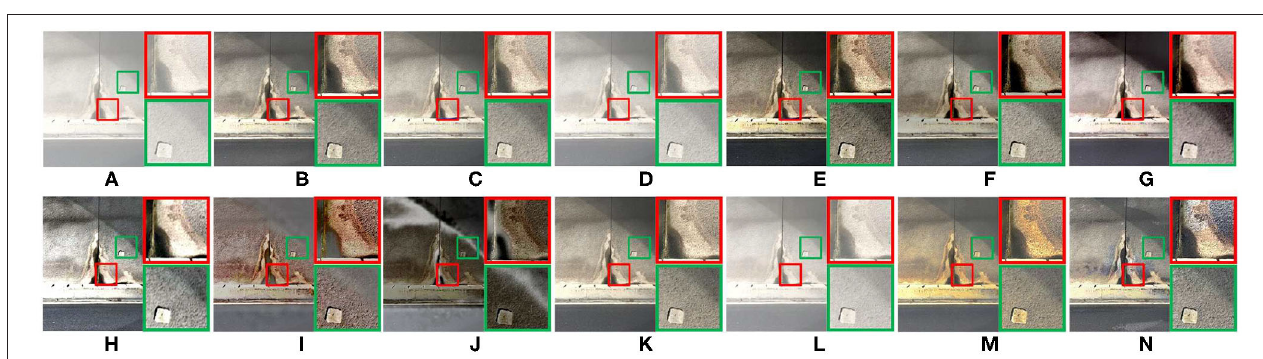
FIGURE 9 | Tunnel image. (A) Represents the original foggy image. (B–N) Represent foggy-free images processed by AMEF, CAP, CO, DCP, DEFADE, GPR, MAMF, OTE, WCD, DehazeNet, FFA-Net, MIF, and the proposed method.